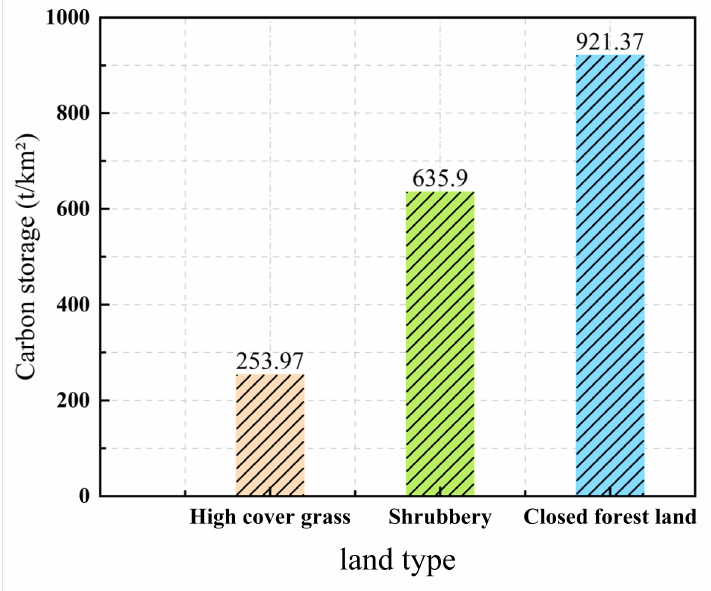
Figure 8. Average carbon storage in 1 km 2 of three ecological